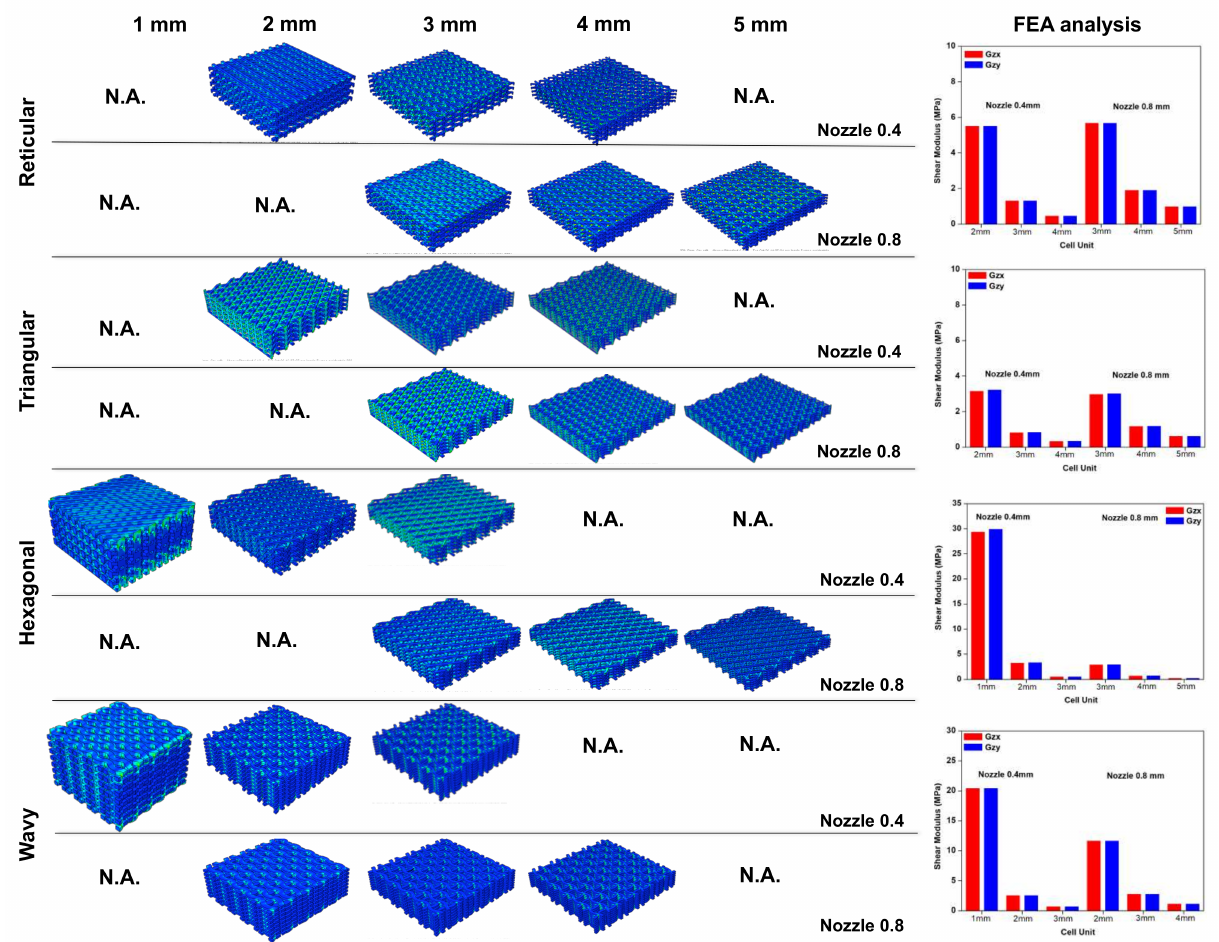
Figure 5. FEM-derived shear moduli. The von Mises stress–strain distribution in the simulated shear test by FEM in the lateral x -direction and estimation of shear moduli of scaffolds with different